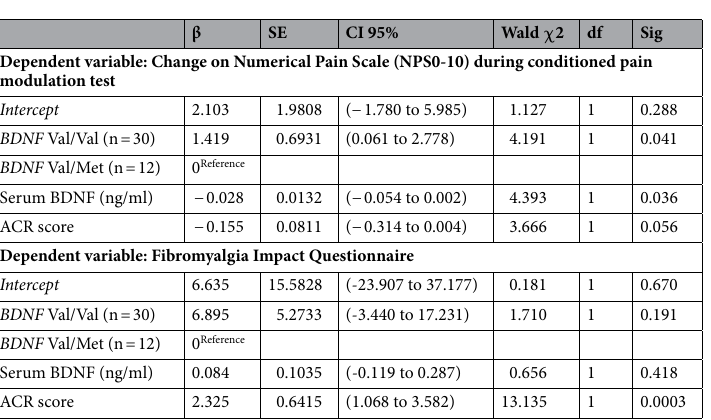
Table 5. Generalized linear model analysis of the relationship between the BDNF Val66Met genotype, serum BDNF and ACR score according to DPMS efficiency and quality of life due to fibromyalgia symptoms (n = 42). Df degrees of freedom . χ 2 Wald Chi-Square . CI confidence interval . β regression coefficient . SE standard error . Sig. p -value. BDNF brain-derived neurotrophic factor . ACR American College of Rheumatology Val/ Val Val66Val homozygous . Val/Met Val66Met heterozygous. The Cramer’s V was used as a measure of